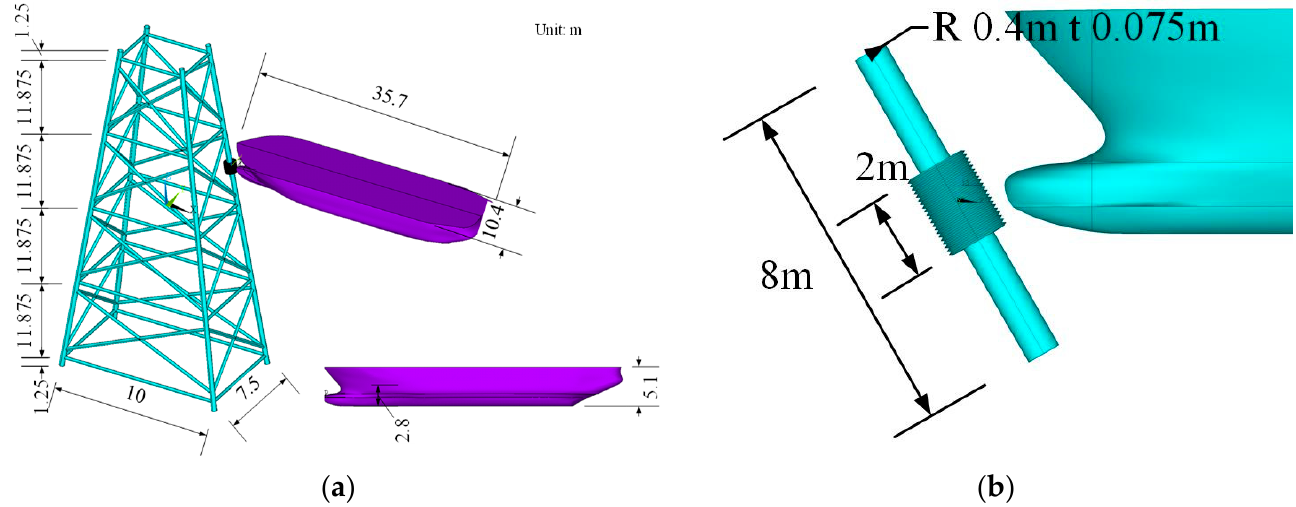
Figure 3. FE model of ship–platform collision [15]. ( a ) FE model of overall structure, ( b ) FE model of local honeycomb-reinforced structure.